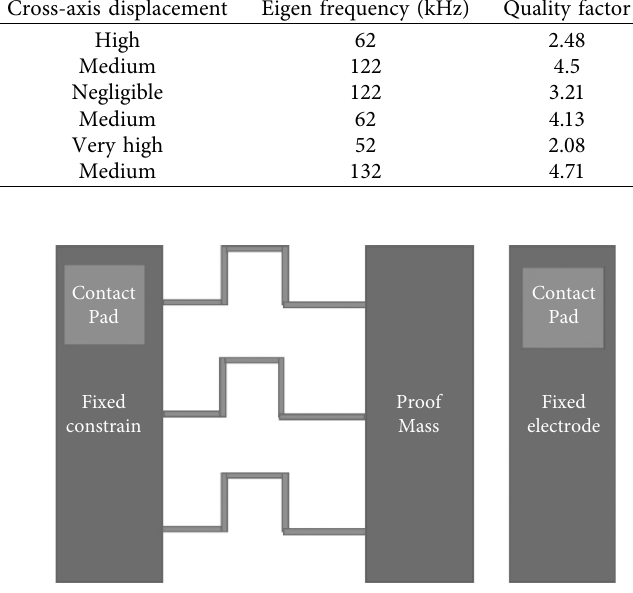
Figure 1: Proposed inertial sensor 1 with three semisquare beams.